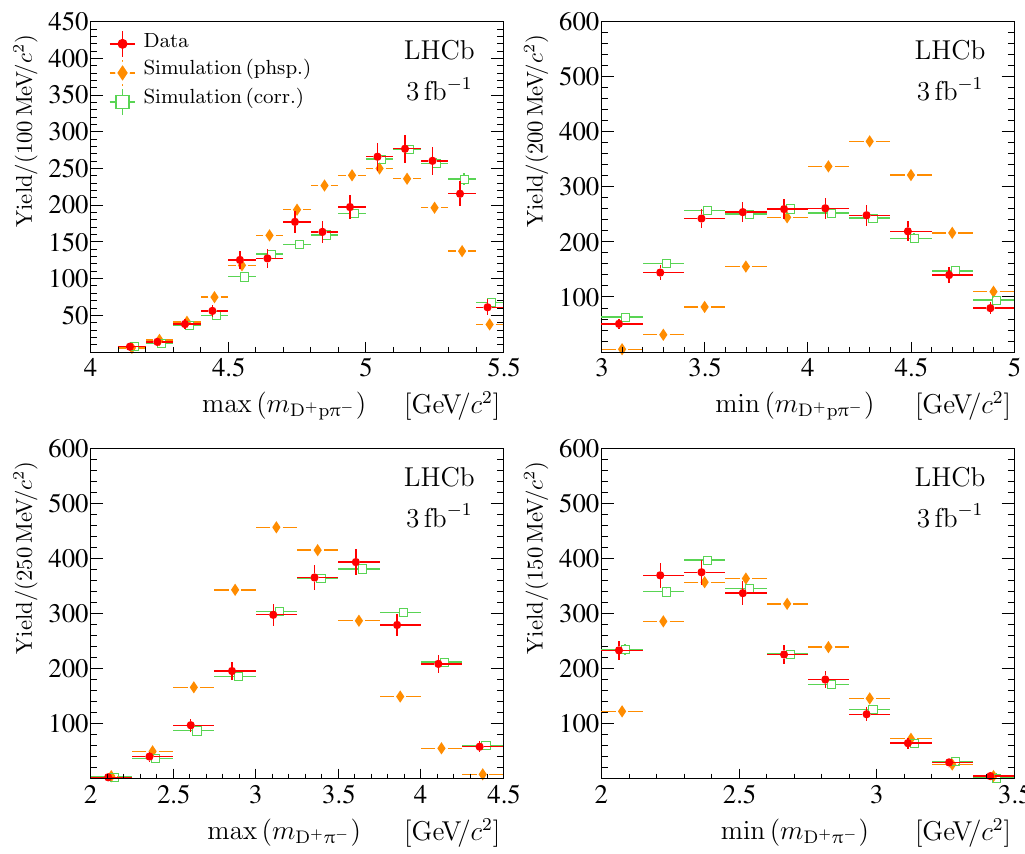
Figure 6 . Background-subtracted maximum and minimum D + pπ − , and maximum and minimum D + π − mass spectra for Λ 0 → D + pπ − π − decays. Expectations from phase-space (phsp.) and b corrected (corr.) simulation are